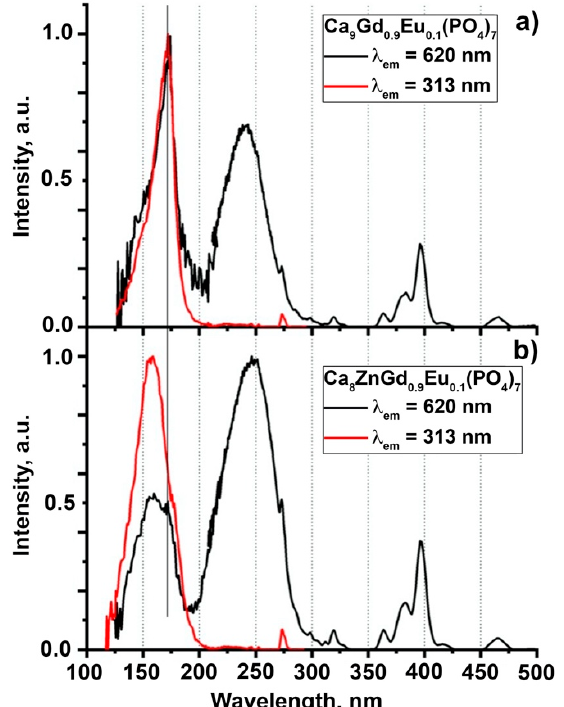
Figure 7. Normalized PLE spectra of Eu 3+ ( λ em = 620 nm, black), Gd 3+ ( λ em = 313 nm, red) in